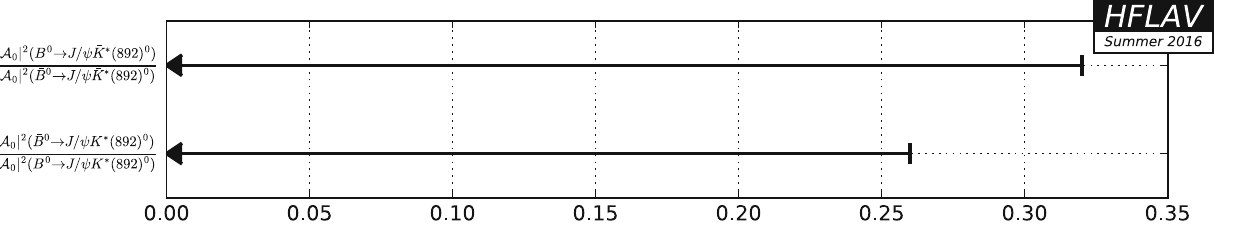
Fig. 98 Summary of the averages from Table 124